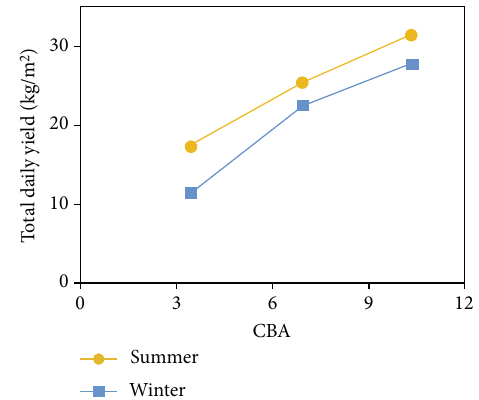
Figure 26: E ff ect of CBA on the total daily yield [62].